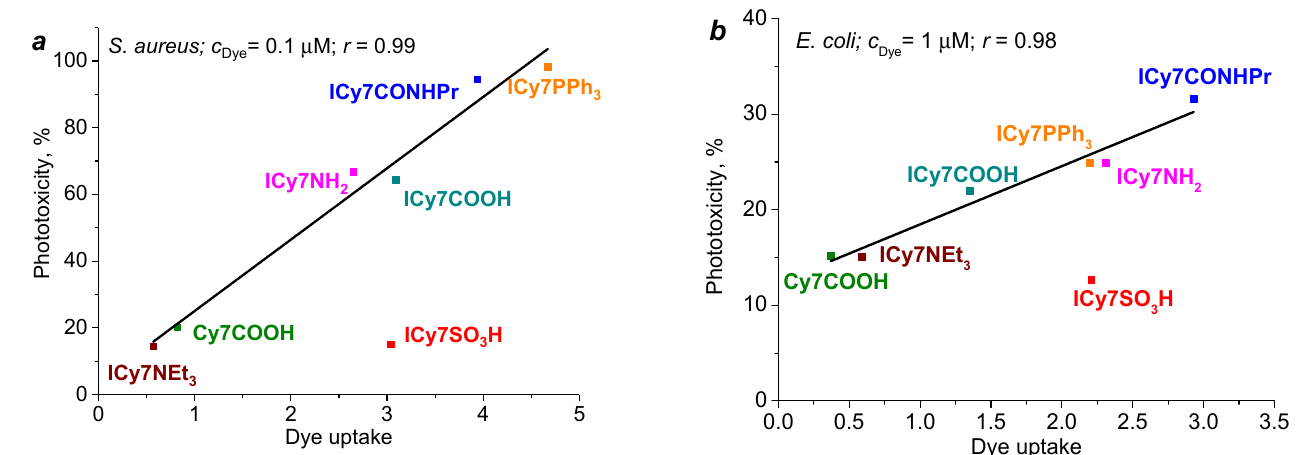
Figure 10. Phototoxicity of the dyes vs. the uptake by S. aureus at c Dye = 0.1 µM ( a )and E. coli at c Dye = 1 µM ( b ). The light doses are 3 J/cm 2 and 100 J/cm 2 , respectively.